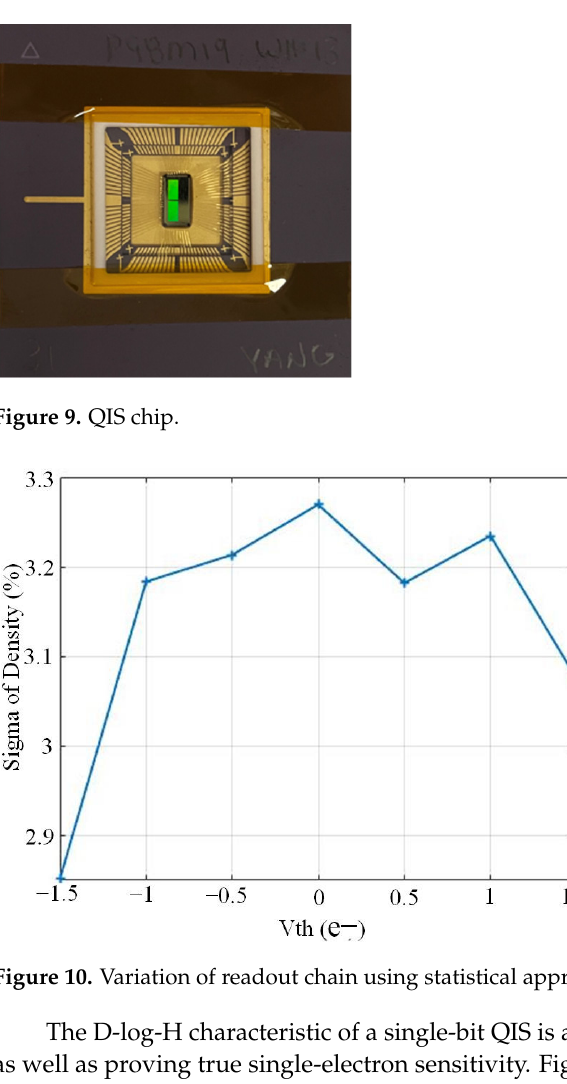
Figure 10. Variation of readout chain using statistical approach from measurements.